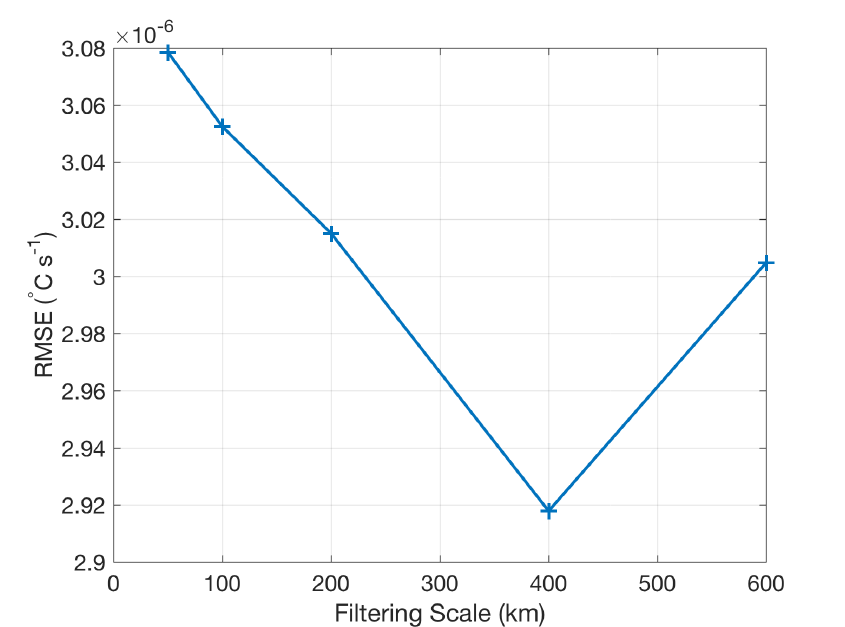
Figure 1. RMSE between the satellite and the in-situ derived forcing term as a function of the D t SST sat filtering